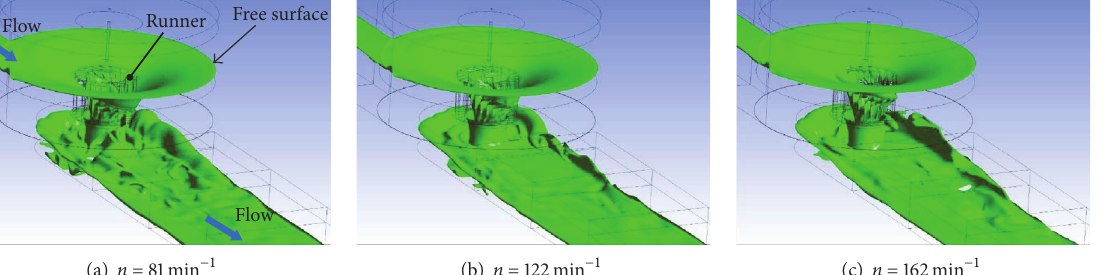
Figure 9: Flow field by calculation.